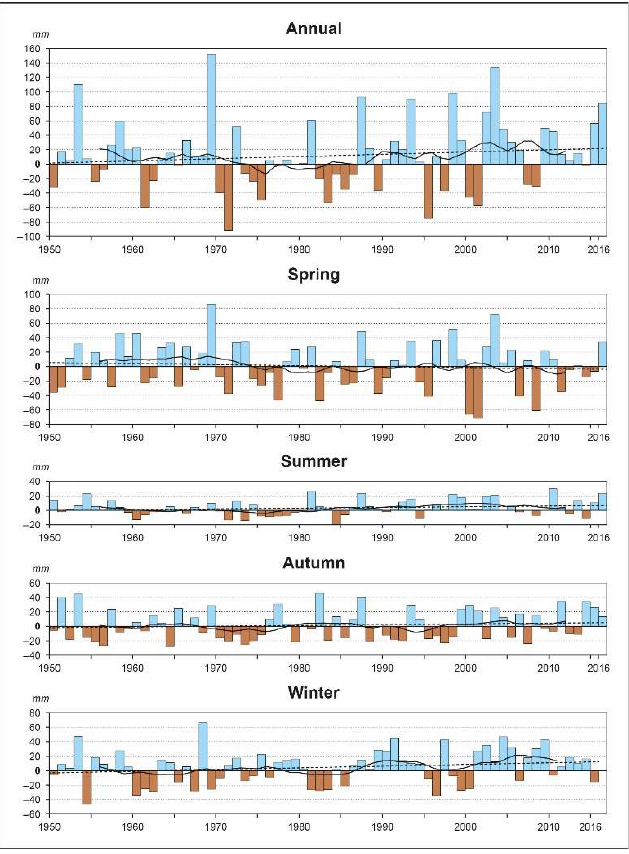
Figure 6. Seasonal and annual precipitation anomaly time series from 1950 to 2016 for the research area. The solid black line is the 10-year moving average line and the dashed black line is the linear trend.